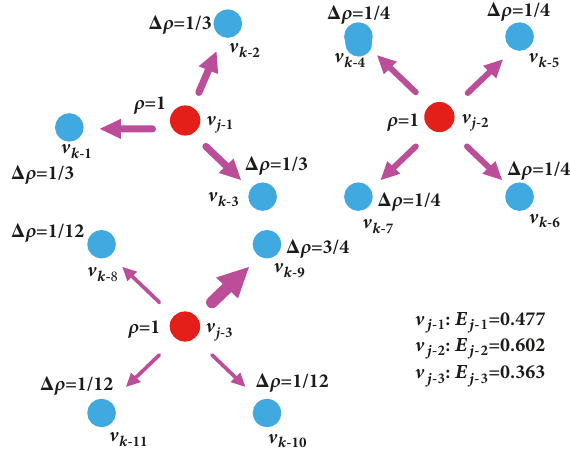
Figure 5: An example to understand